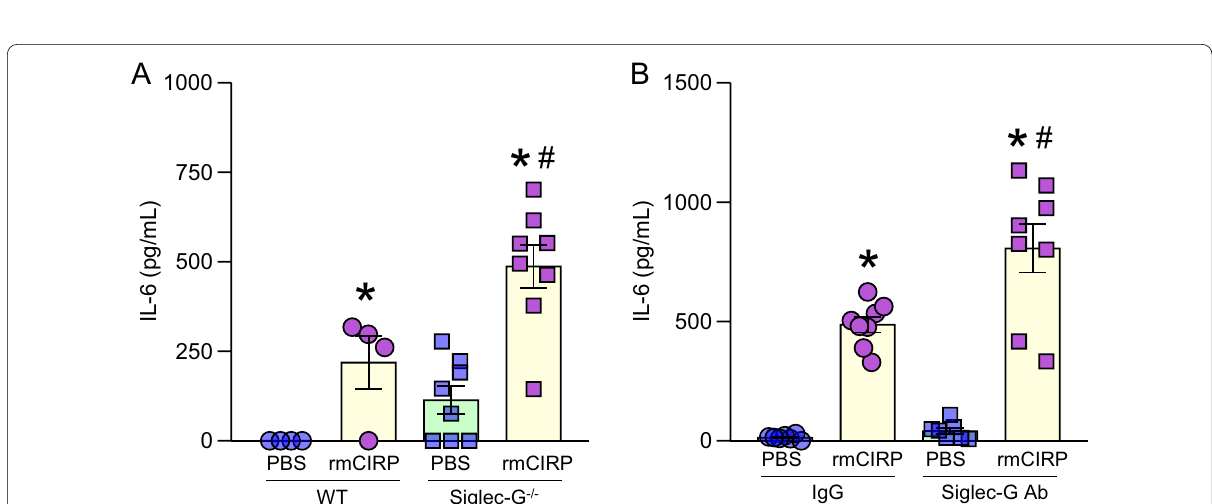
Fig. 5 An absence of Siglec-G results in greater production of IL-6 by B-1a cells in response to rmCIRP than WT cells. A PerC B-1a cells were collected from WT and Siglec-G − / − mice and stimulated in vitro with rmCIRP or PBS vehicle for 24 h. Supernatant was assessed by ELISA for IL-6 production. Data are expressed as means SE (n 4–8 mice/group) and compared by one-way ANOVA and Student–Newman–Keuls (SNK) ± = method (*p < 0.05 vs. WT PBS treated mice and #p < 0.05 vs. WT rmCIRP treated mice). B Blocking Siglec-G by its neutralizing Abs increases IL-6 production following rmCIRP treatment. PerC B-1a cells were collected from WT mice and pretreated with Siglec-G blocking Ab or IgG control. The cells were stimulated in vitro with rmCIRP or PBS vehicle for 24 h. Supernatant was assessed by ELISA for IL-6 production. Data are expressed as means SE (n 8 mice/group) and compared by one-way ANOVA and Student–Newman–Keuls (SNK) method (*p < 0.05 vs. PBS IgG treated mice ± = and # p < 0.05 vs. rmCIRP IgG treated